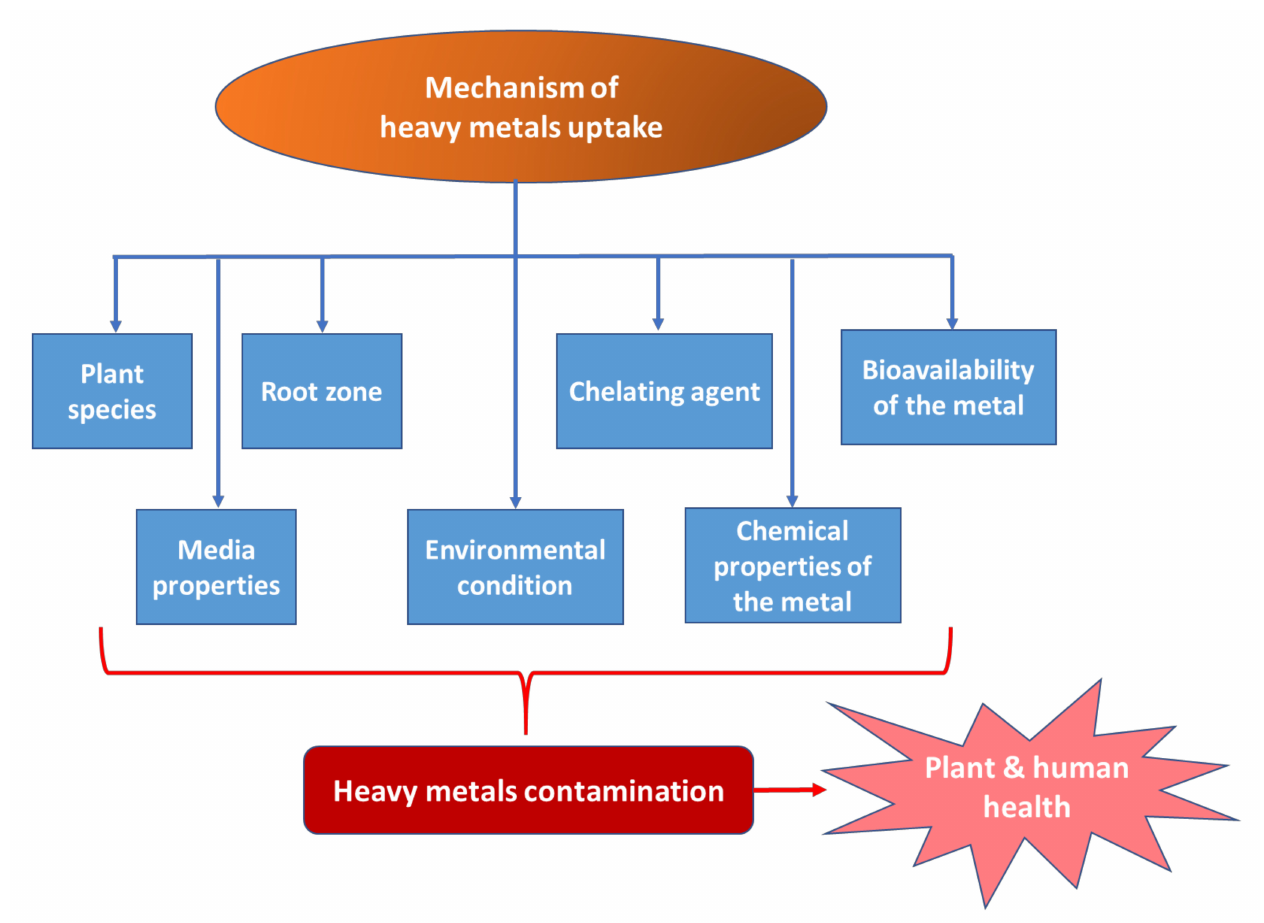
Figure 2. Factors which are affecting the uptake mechanisms of heavy